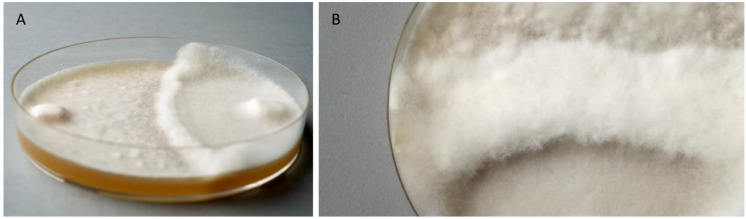
Fusion test of the two Rhodonia placenta strains growing on one plate. (A) FPRL280 (left side) and MAD-698 (right side), 2 weeks after incubation, clearly showing the formation of a barrier, which is not overgrown. (B) The barrier got thicker and neither of the fungi overgrew it.